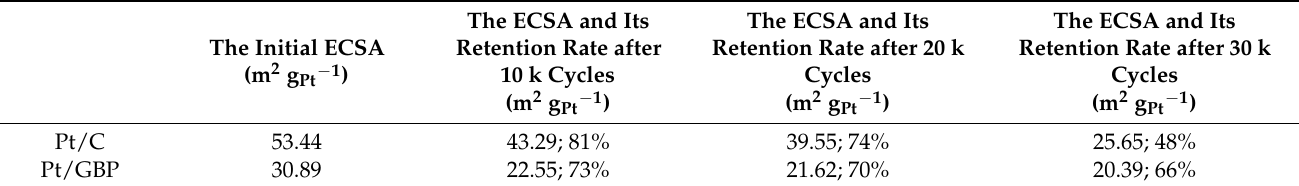
Table 5. The ECSA retention rate of Pt/C and Pt/GBP during 30 k cycles (0.6–1.0 V).